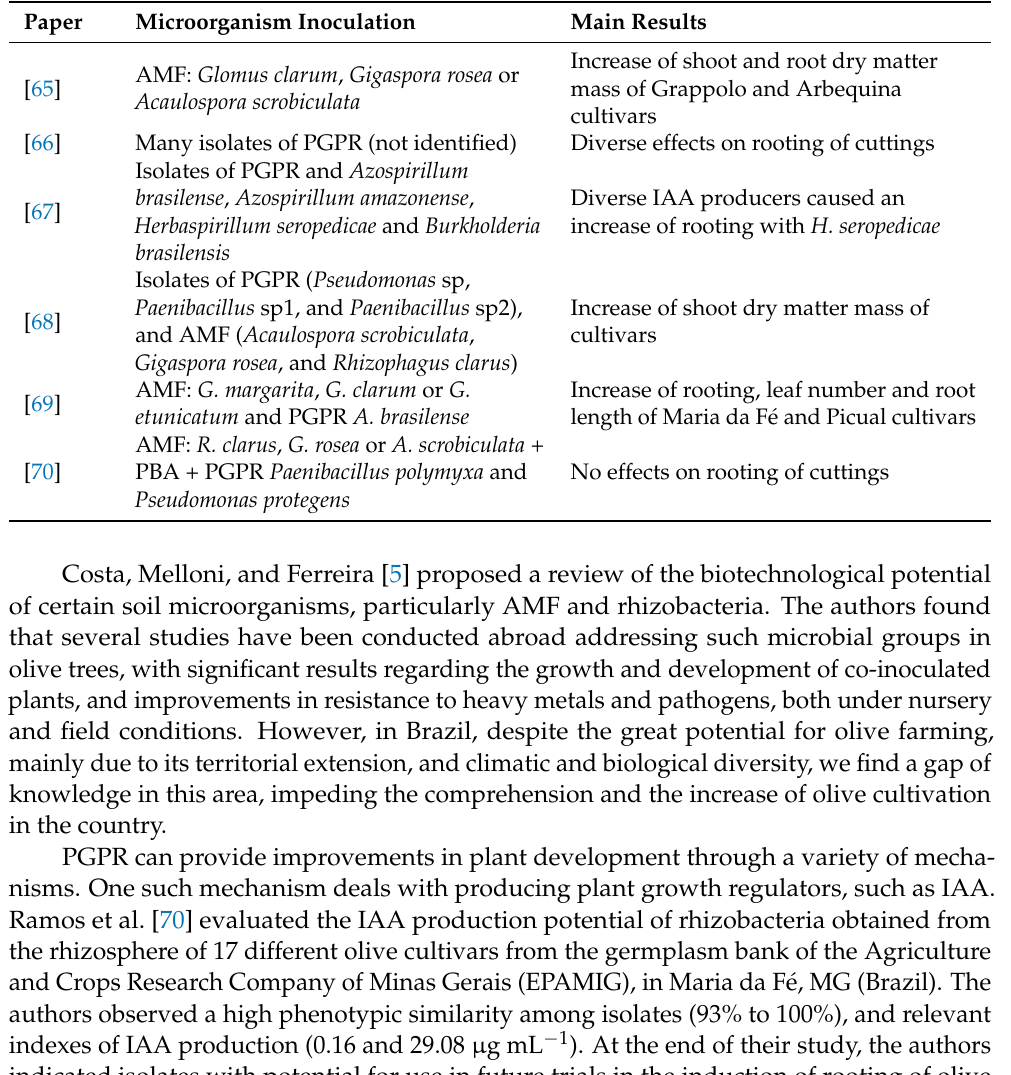
Table 3. Effects of microorganism inoculation in olive tree cuttings cultivated in